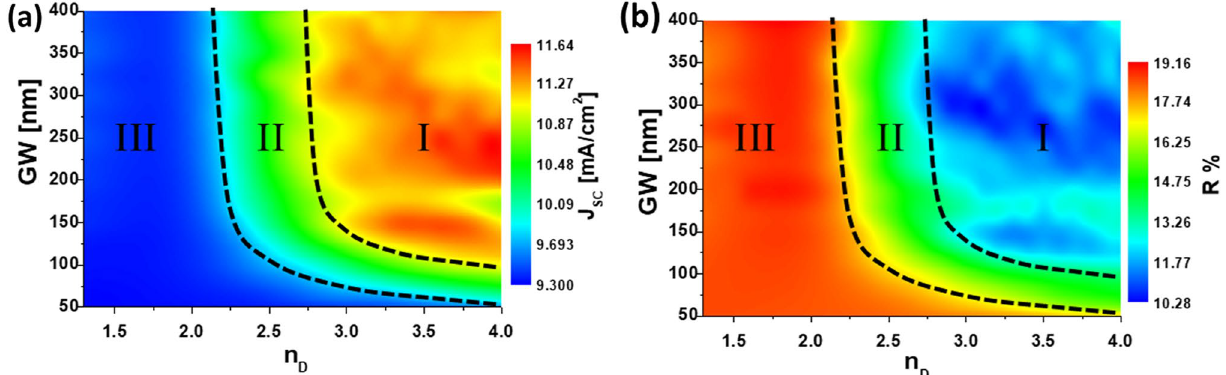
Figure 2. Maps of the short-circuit current ( a ) and total reflectance ( b ) in terms of the index of refraction of the dimer’s material and the lateral size, GW, of the cuboid element. The reflectance of the whole device, R , is calculated in the range (cid:31) ∈ [ 300, 800 ] nm. The dashed curves define three regions in